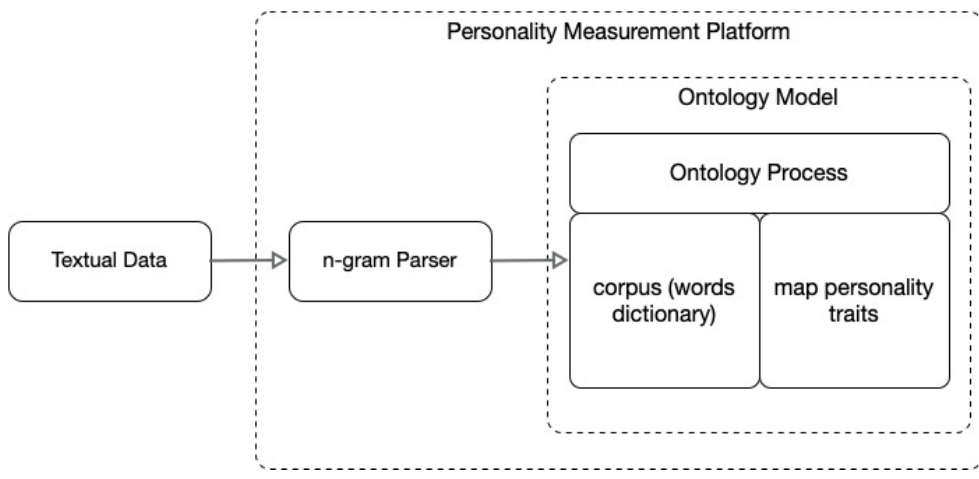
Figure 1. Ontology model workflow under Personality Measurement